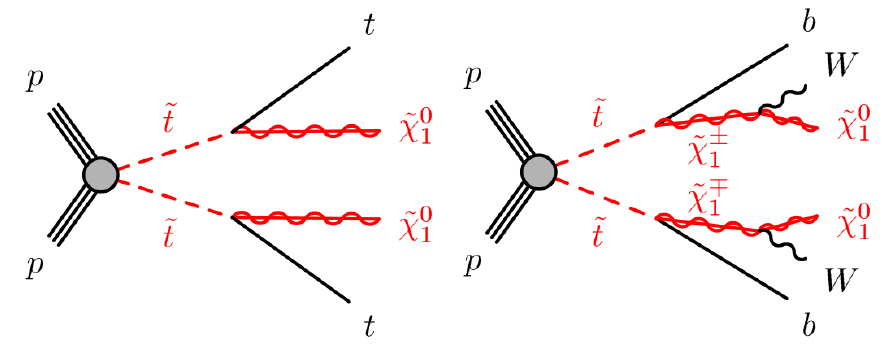
Figure 1 . Diagrams illustrating the stop decay modes, which are referred to as (left) ~ t (cid:6) (right) ~ t b ~ (cid:31) 1 . Sparticles are shown as red lines. In these diagrams, the charge-conjugate symbols 1 ! are omitted for simplicity. The direct stop production begins with a top squark-antisquark